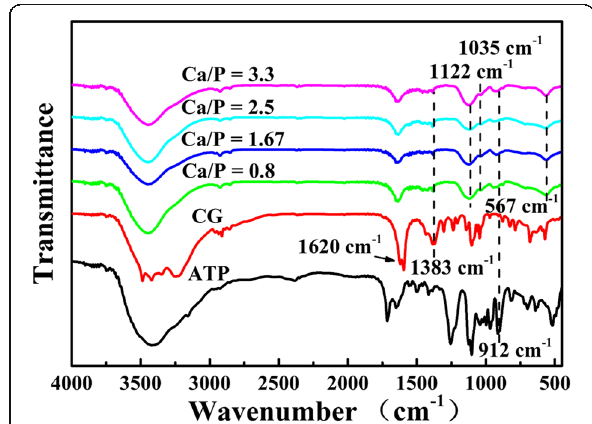
Fig. 2 FTIR spectra of ATP-CG microspheres synthesized with various Ca/P at 120 °C for 15